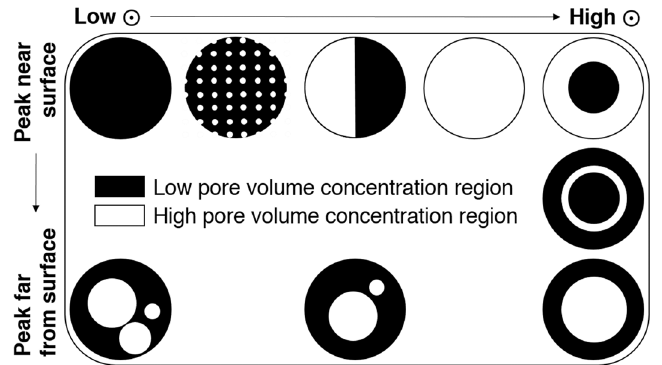
Figure 6. Visual representation of the meanings of peaks in pore volume with respect to distance from the nearest particle surface. ⨀ is related to peak height. Simplified example distributions are presented here to aid in interpretation of Figs. 5 and 7.